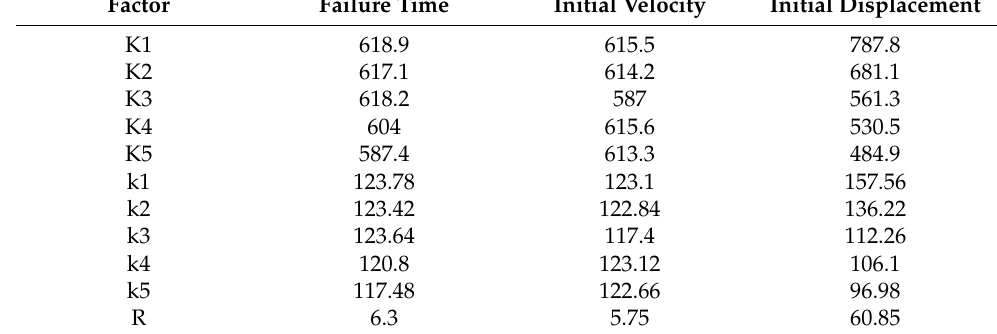
Table 5. Orthogonal test table when the bottom inner column fails.